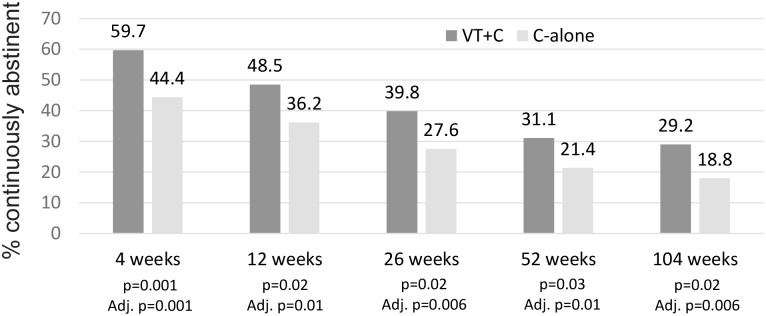
Continuous smoking abstinence between weeks 4 and 104; Self-reported continuous abstinence defined as smoking ≤ 5 cigarettes between from week 2 to respective follow-up period.Intention-to-treat analysis used (n = 196 per arm) with data above bar representing % abstinence. P-values are unadjusted and adjusted for baseline differences observed between disciplines.